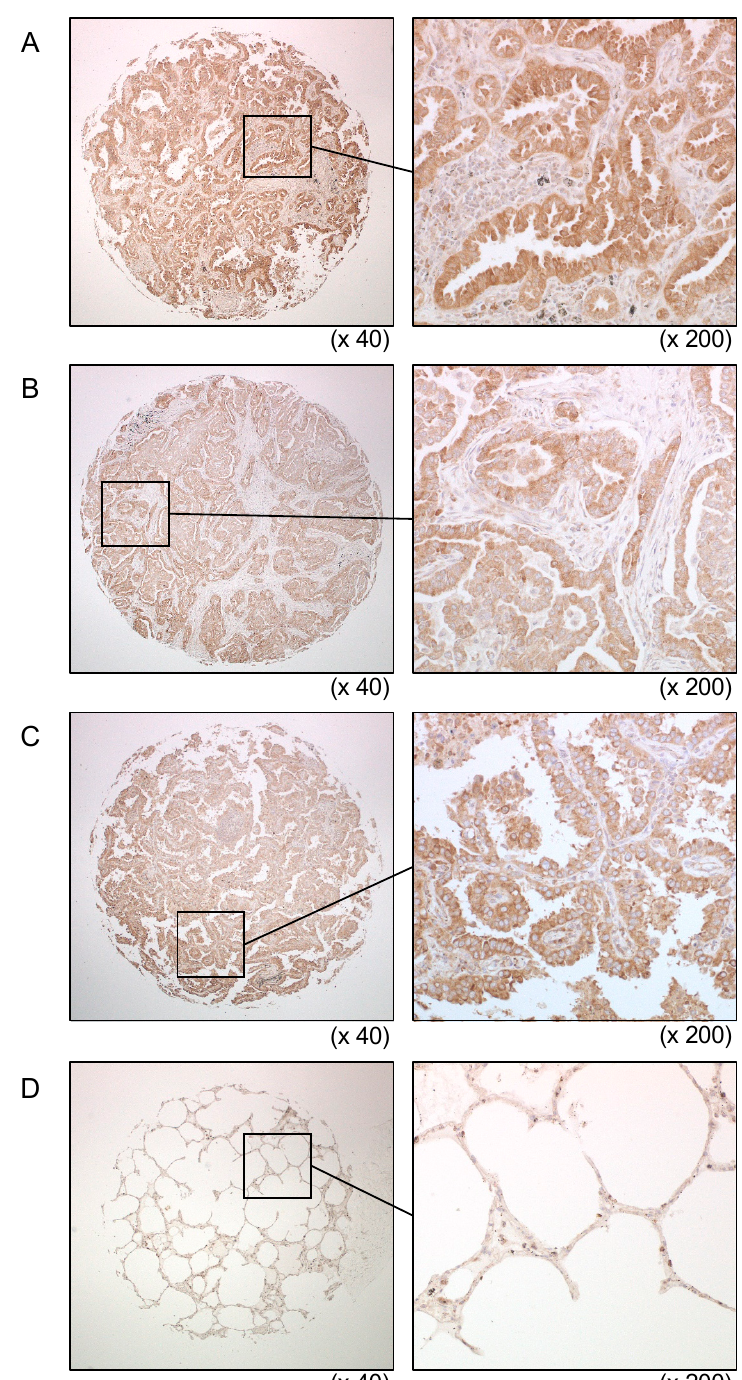
Figure 8. Overexpression of FAM64A in LUAD clinical specimens. ( A – C ) Immunohistochemical staining of FAM64A in LUAD tissues. Overexpression of FAM64A was detected in the cytoplasm and / or nuclei of cancer cells. On the other hand, expression of FAM64A was low in normal lung cells ( D ).